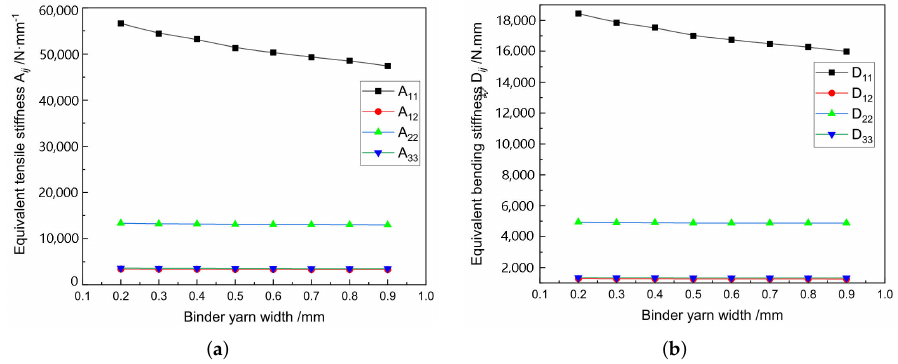
Figure 13. Influence of the binder yarn width on equivalent stiffness of 3D-TCP. ( a ) A ij ; ( b ) D ij .